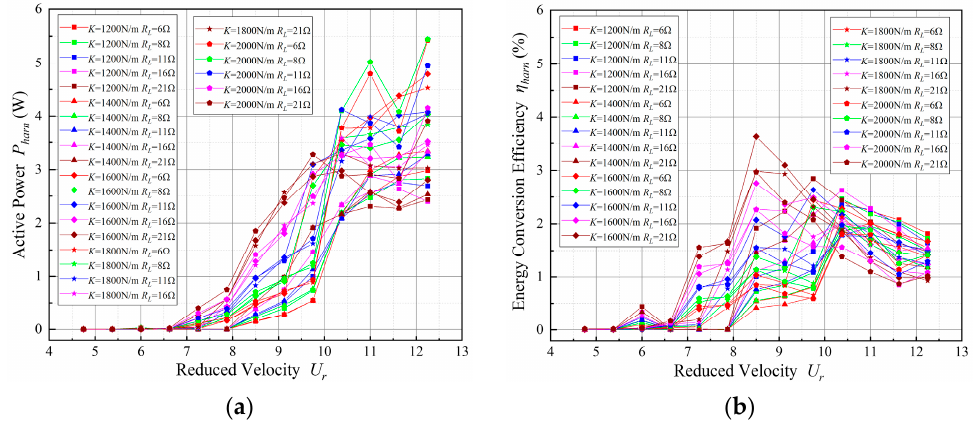
Figure 17. Active power and energy conversion efficiency for L / D = 1.5. ( a ) Active power; ( b ) Energy conversion efficiency.